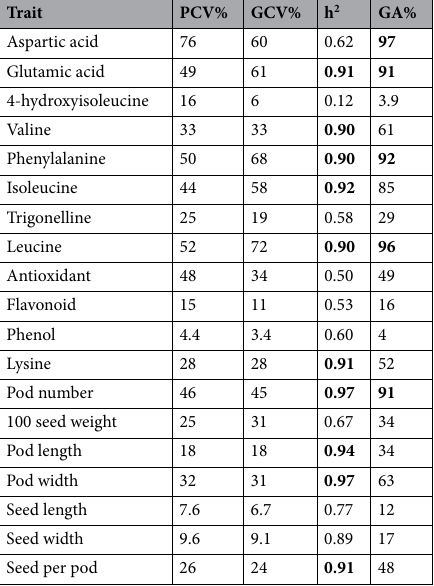
Table 2. PCV, GCV, h 2 , and GA of yield related traits and metabolic traits. The heritability and GA ≥ 90% are shown in